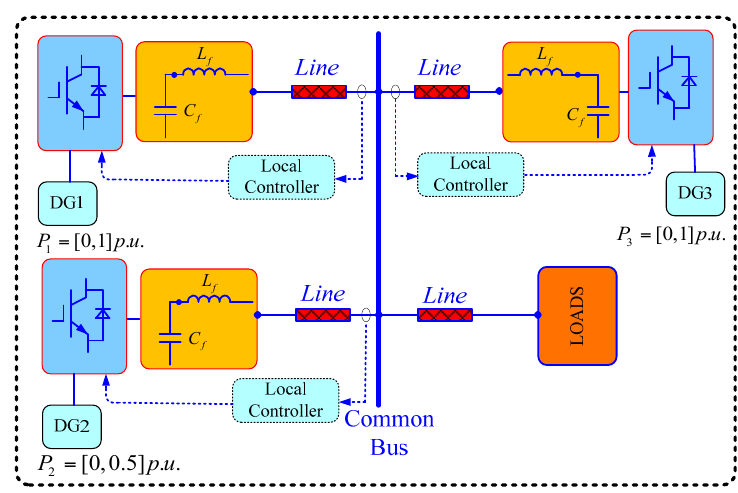
Figure 2. A conceptual diagrams of a typical AC microgrid (MG).